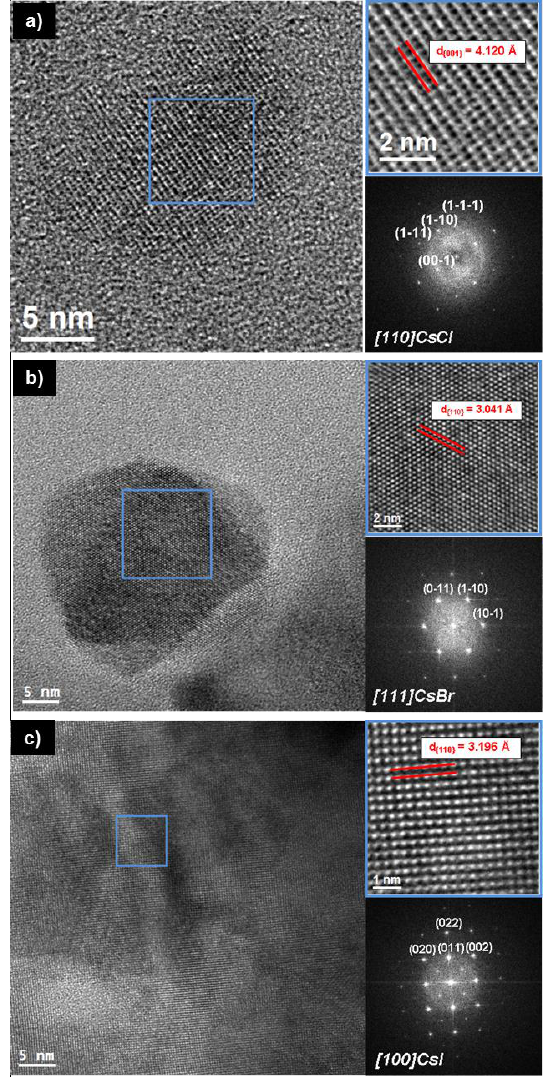
Figure 2. HRTEM and power spectrum analysis of CsX nanocrystals. ( a ) CsCl nanocrystal in a view along the [110] zone axis. ( b ) CsBr nanocrystal in a view along the [111] zone axis. ( c ) CsI nanocrystal in a view along the [100] zone axis. Despite the morphological changes induced by the inelastic interaction between electron beam and sample, due to the high ordering in strongly ionic compounds, it is possible to obtain lattice